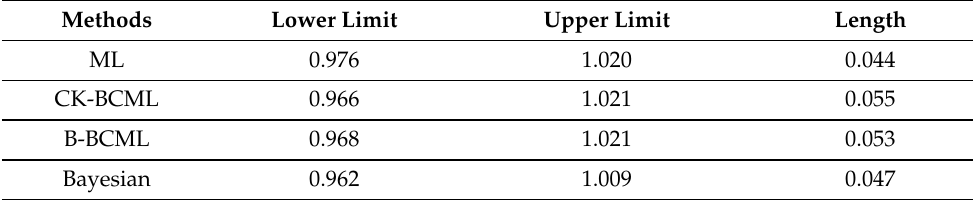
Table 7. The 95% ACI and HPDI of PPI for L = 0.2.